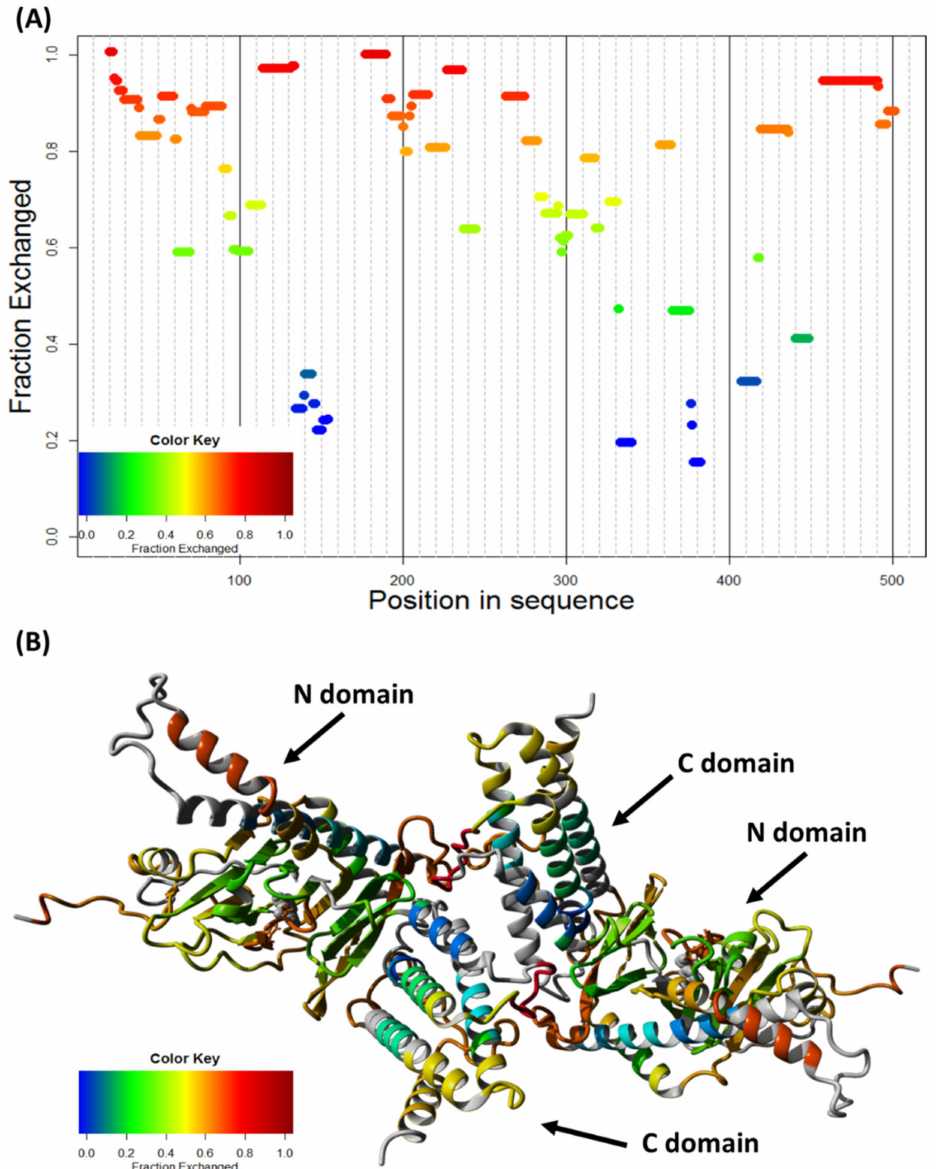
Figure 8. FTO dimer selection based on HDX data. ( A ) HDX profile of BES FTO in the presence of Fe 2+ and 2-OG, showing distribution of peptides (rectangles) colored according to the hydrogen exchange extent after 1 h. Two regions are substantially less solvent-accessible than the rest of the protein, residues 130–160 and 330–420. ( B ) Model of FTO homodimer connected through C-domains presented in Figure 7C, colored according to HDX exchange